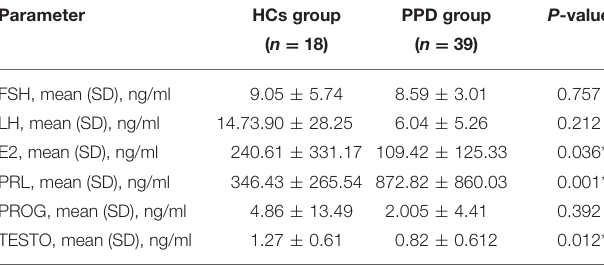
TABLE 2 | Sex hormone levels in patients with PPD and HCs. Parameter